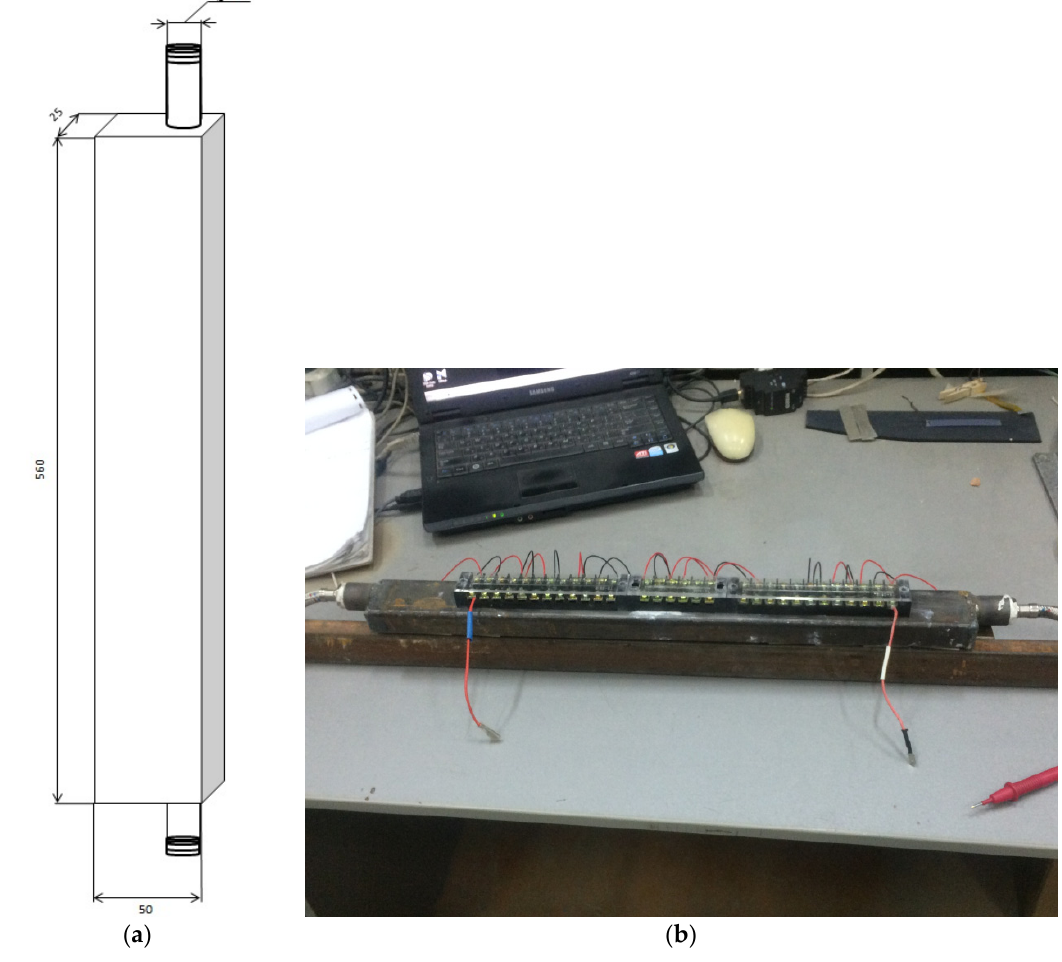
Figure 6. Steel water cooling radiator for the thermoelectric converter: ( a ) drawing; ( b ) appearance.